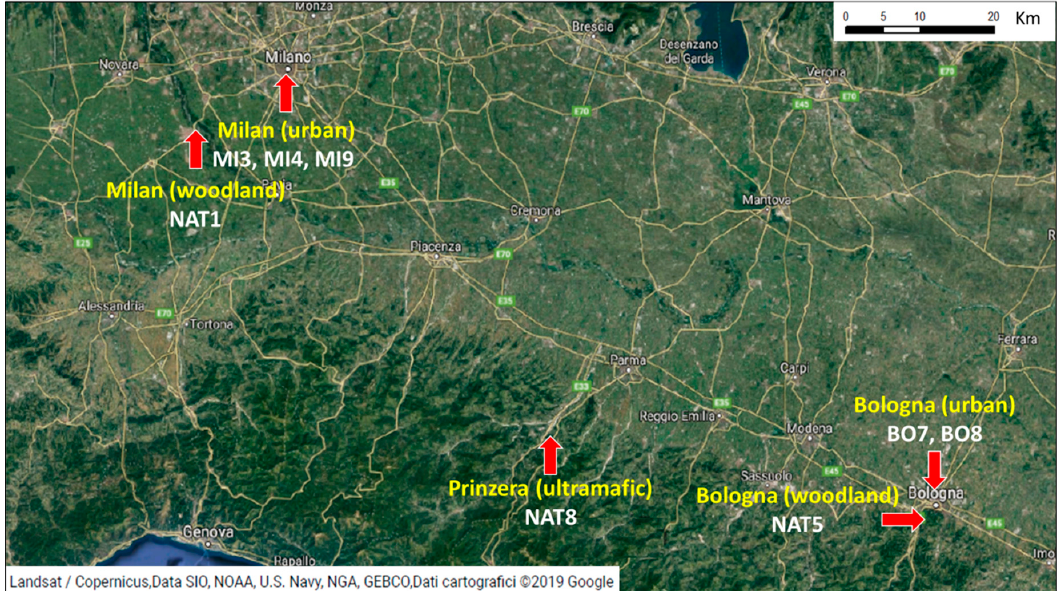
Figure 1. Sampling locations of soils and plants used in the study. In each station one soil sample and three plant species have been collected.